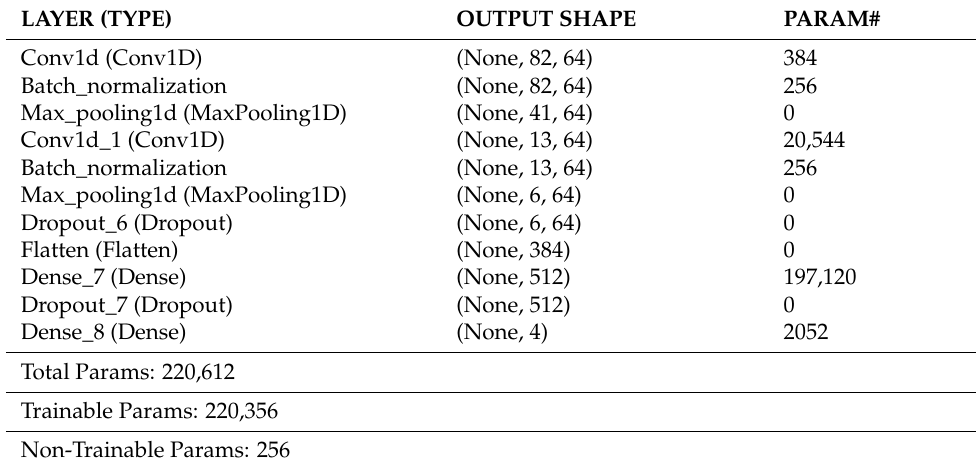
Table 3. Designed CNN sequential model